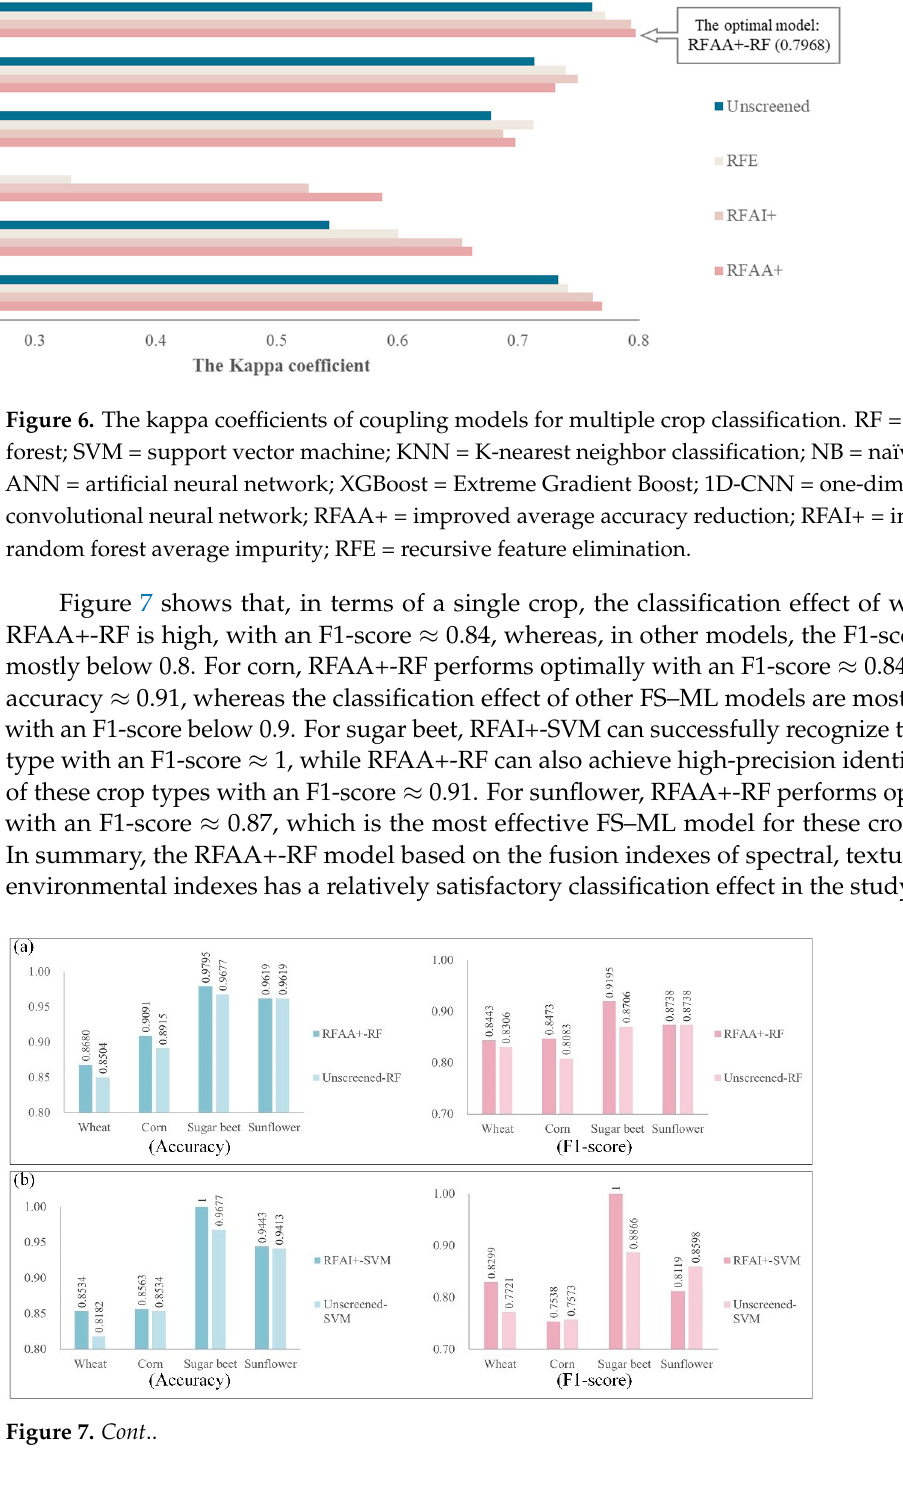
Figure 5. Sample data distribution map.